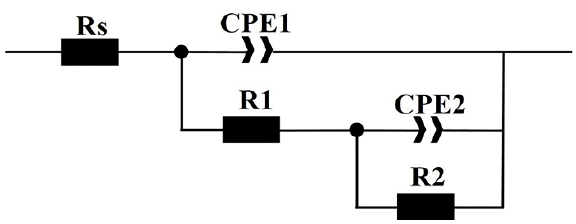
Figure 8. Equivalent circuit diagram. Table 2. Fitting parameters of the potentiodynamic polarization curve of specimens in 3.5 wt.% NaCl solution. Icorr: corrosion current density, Ecorr: corrosion potential, IP: pitting current density, Epit: pitting potential. Table 3. Electrochemical impedance spectrum fitting parameters of the specimens in 3.5 wt.% NaCl solution.